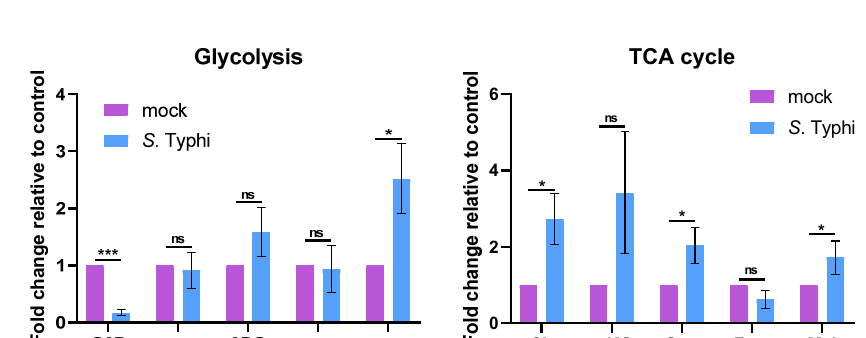
ure 1B), gene expression of almost all the enzymes involved in OXPHOS and the TCA